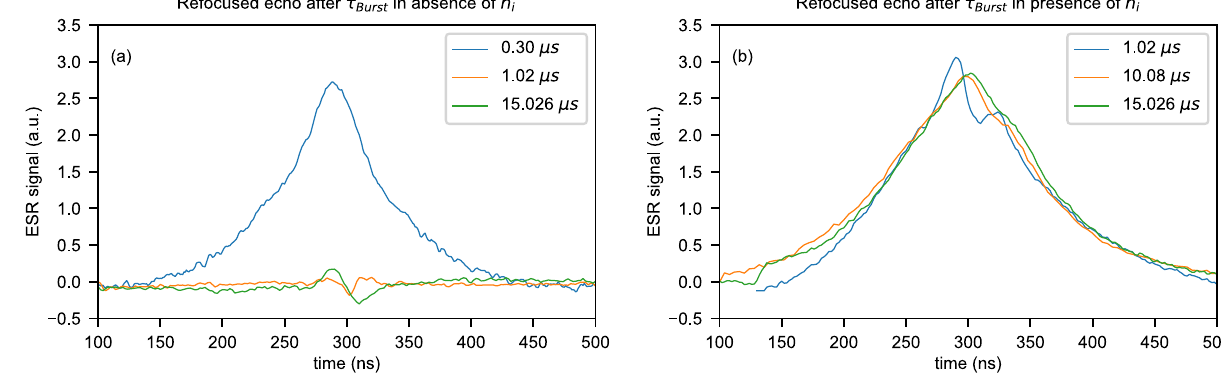
Z measured after a Rabi burst +